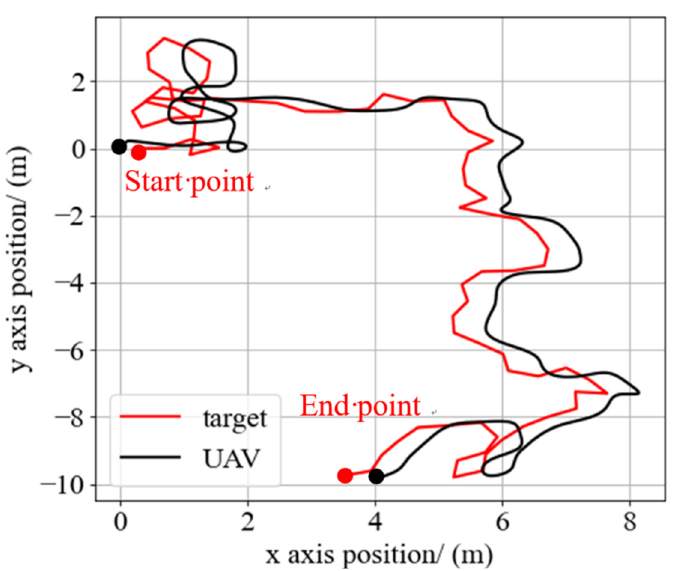
Figure 9. The trajectory of the UAV and target during the tracking process in the simulation test.